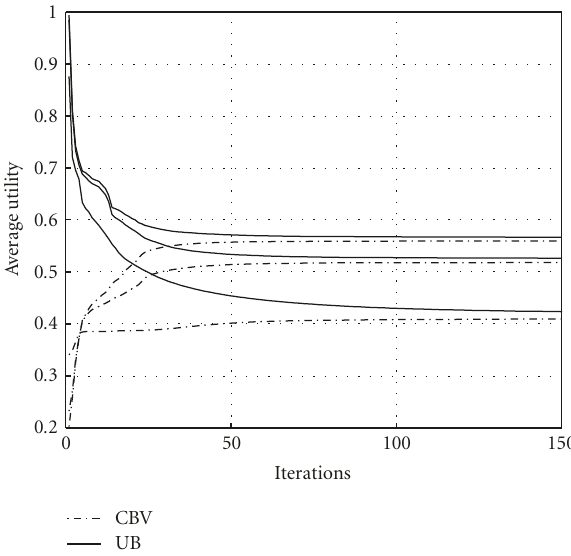
Figure 6: Average utility versus number of iterations, PB